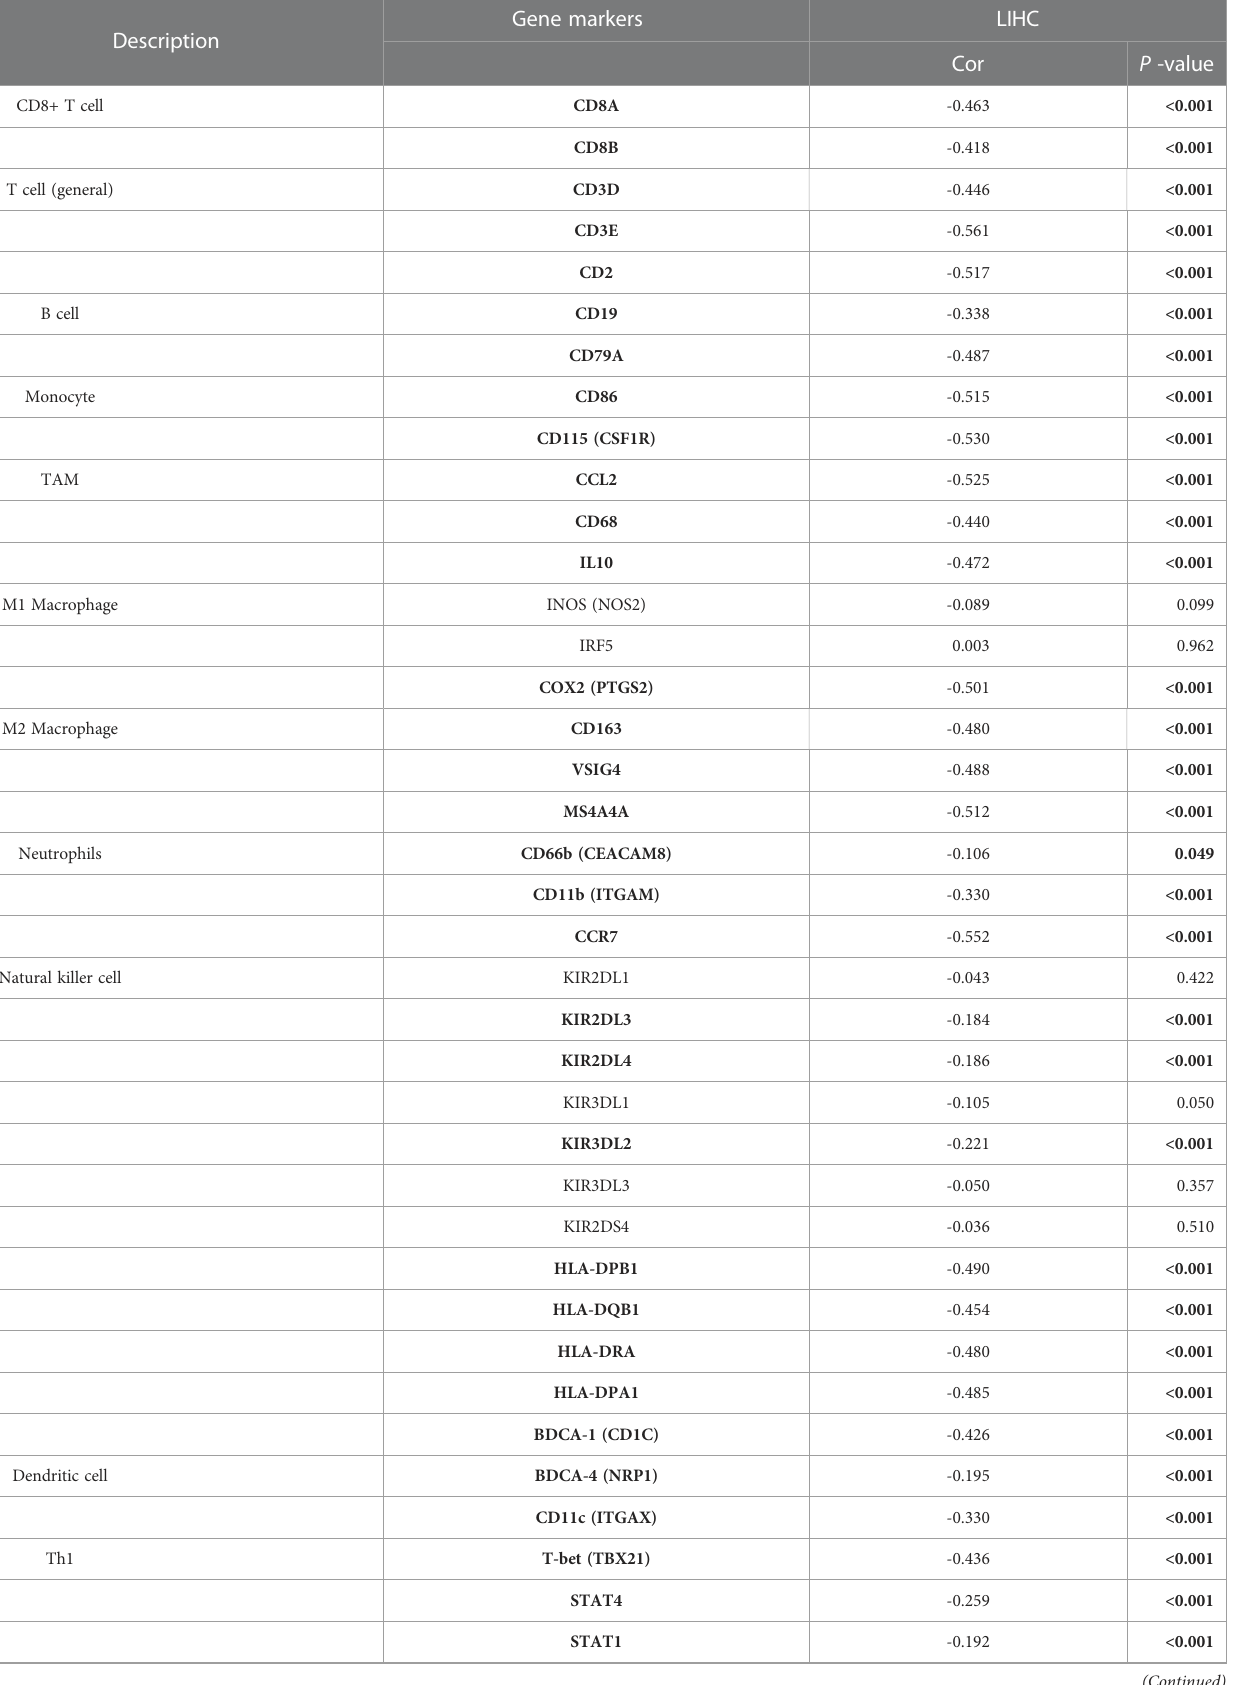
TABLE 3 Correlation analysis of RAB22A expression with immune cell